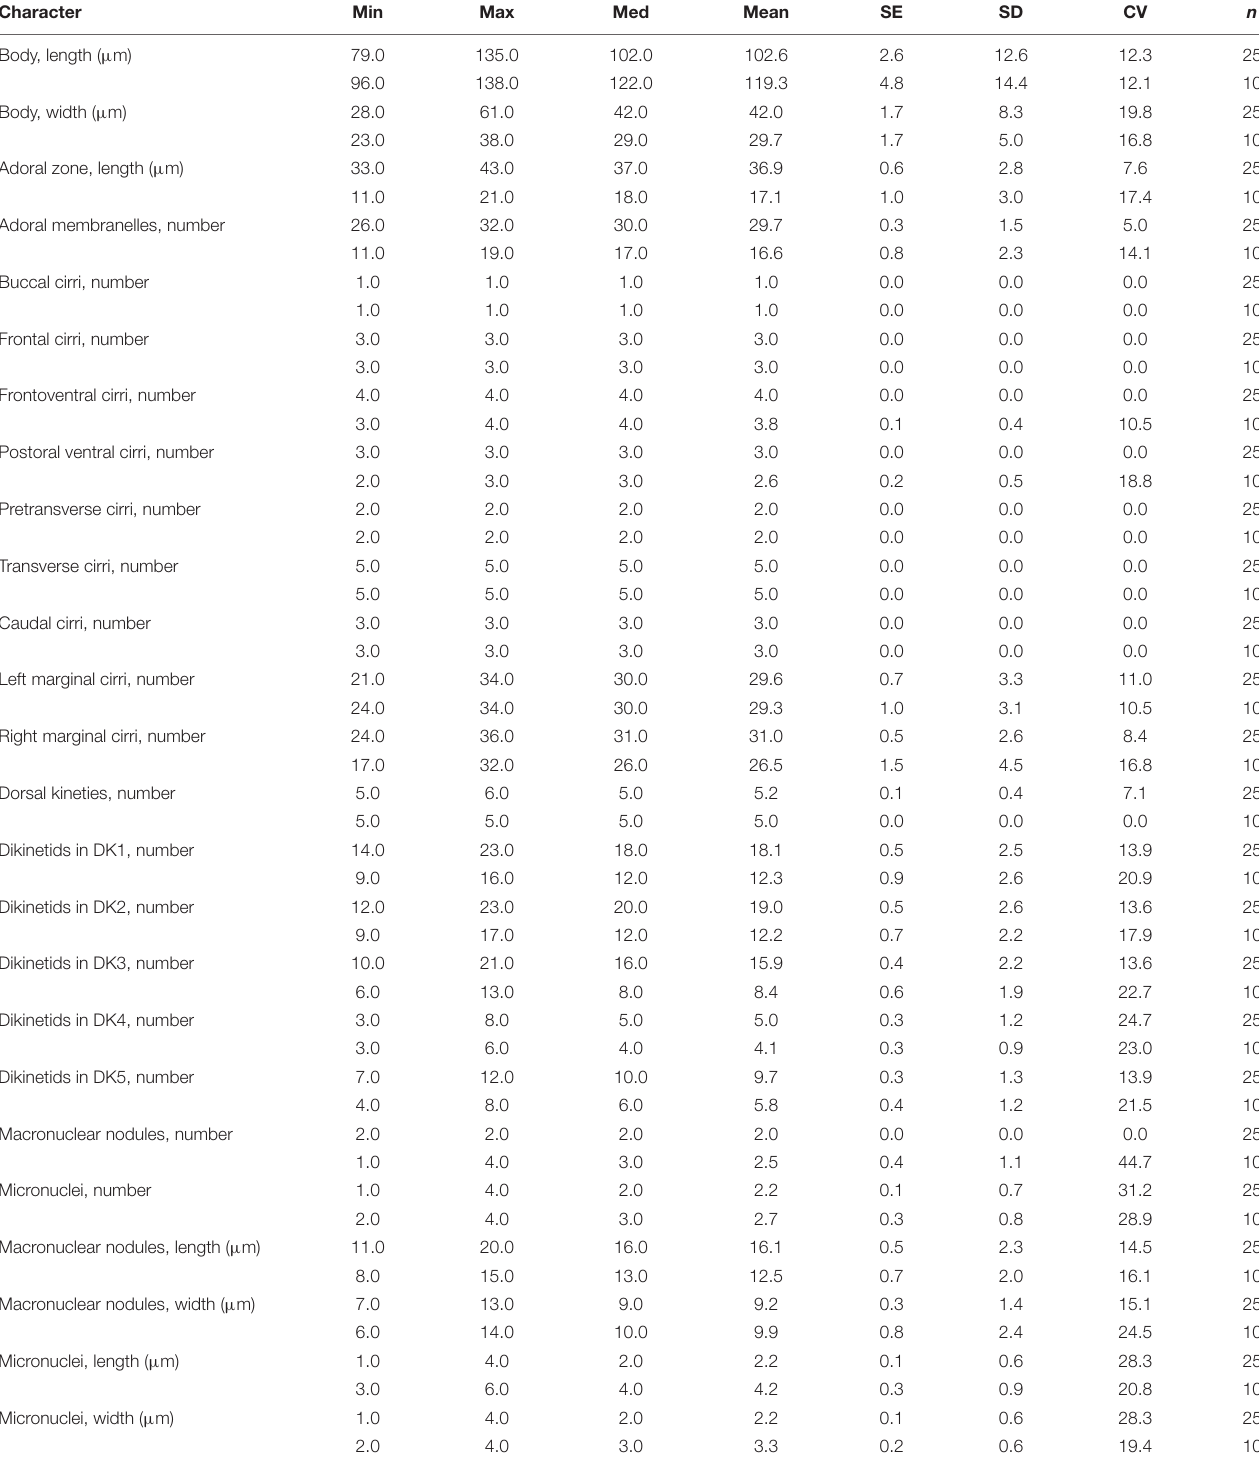
TABLE 1 | Morphometric data of normal (upper lines) and abnormal (lower lines) specimens of Oxytricha granulifera granulifera in the present work.